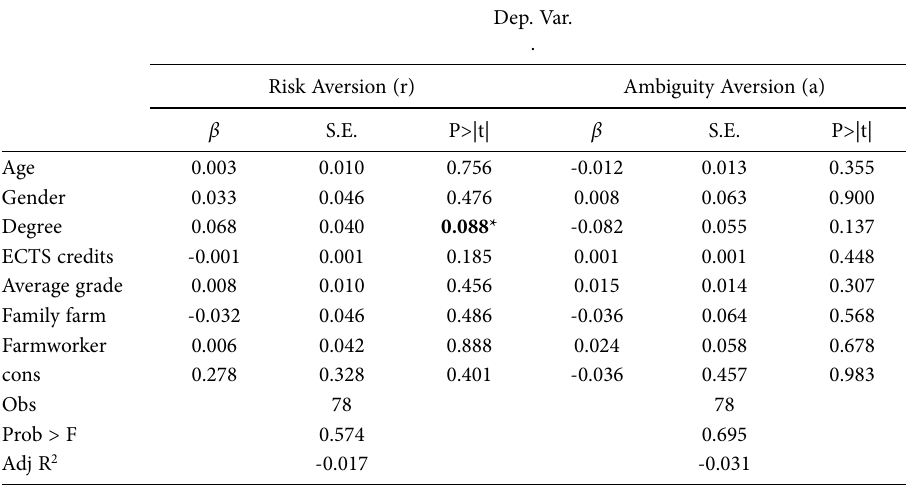
Table 3. OLS - Risk Aversion (r) and Ambiguity Aversion (a).